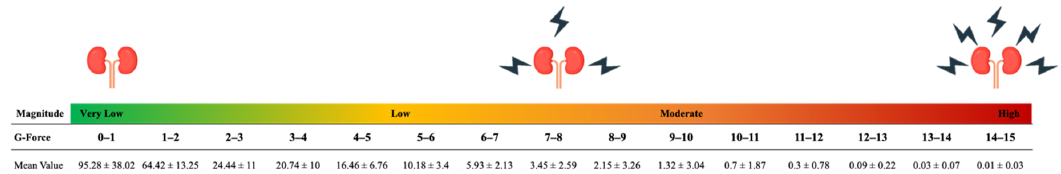
Figure 2. Mean values of impacts per minute associated with 15 g-force categories during off-road mountain running.